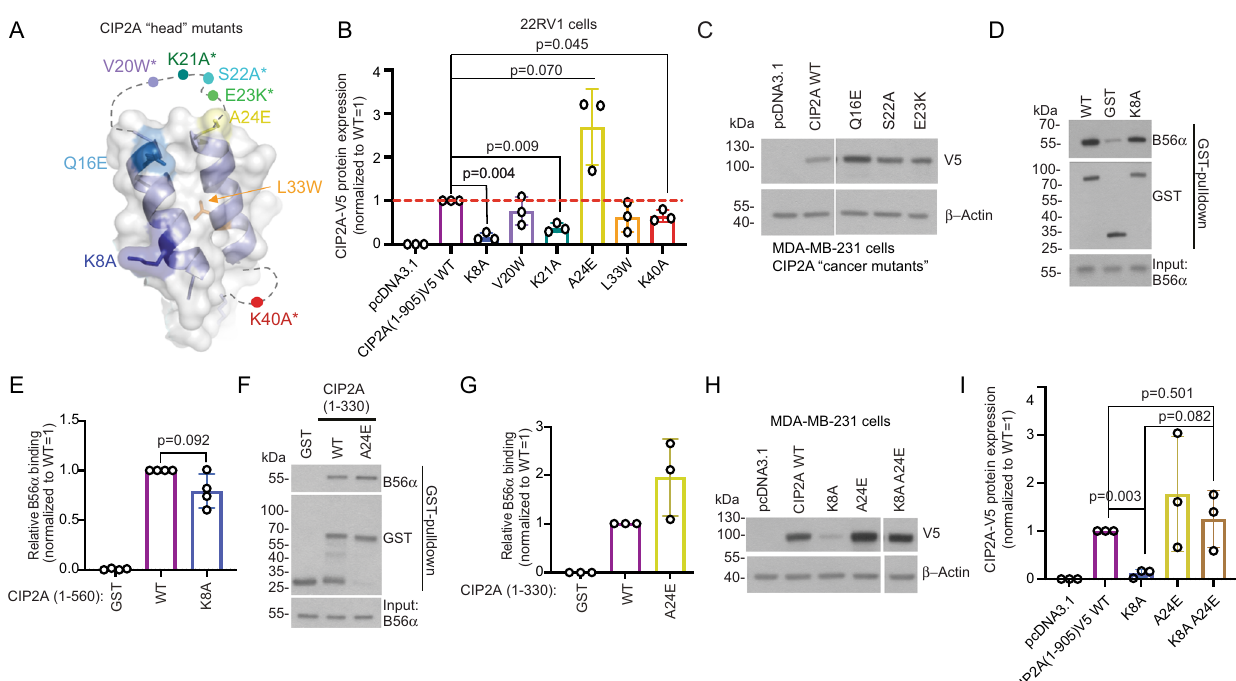
Fig. 2 | The N-terminal head domain stabilizes CIP2A protein expression in cancer cells. A Mutations on the N-terminal head of CIP2A (PDB: 5UFL) are indi- cated with different colours used also in bar graphs B,E,G,I. B Transient over- expression of full-length CIP2A(1-905)V5 variants in prostate cancer 22RV1 cells. Representative Western blot images are shown in S5. Quanti fi cation is shown as a mean + S.E.M. from N =3 biological repeats. Expression levels of CIP2A mutants were normalized to expression of WT CIP2A, which was set as value 1 in each experiment. Two-tailed One sample Wilcoxon t test. Source data are provided as a SourceData fi le. C Impactof cancer-derived CIP2Aheaddomainmutantson CIP2A full length protein expression in breast cancer MDA-MB-231 cells. D , F GST pull- down assay comparing direct B56 α interaction between recombinant GST-tagged CIP2A(1-560) WT protein and K8A or A24E mutants. Source data are provided as a